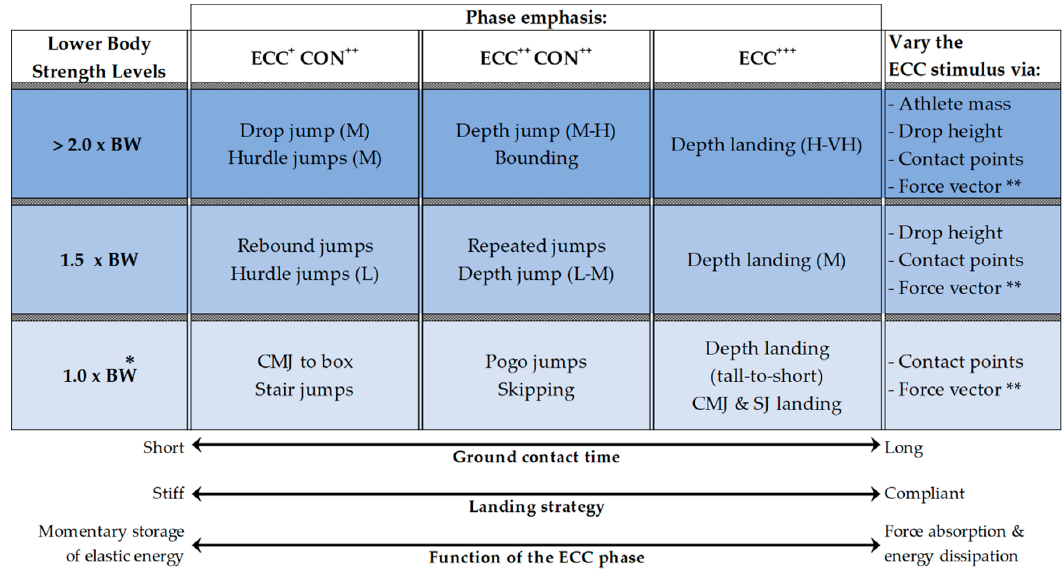
Figure 2. Characteristics and progressions of plyometric exercise to emphasize eccentric loading for athletes of varying strength level. ECC = eccentric; CON = concentric; + = low emphasis; ++ = moderate emphasis; +++ = high emphasis; L = low height; M = moderate height; H = high height; VH = very high height; * = overall priority on correct skill execution and landing mechanics, ** = not applicable to exercises requiring landing only (ECC +++ column) .